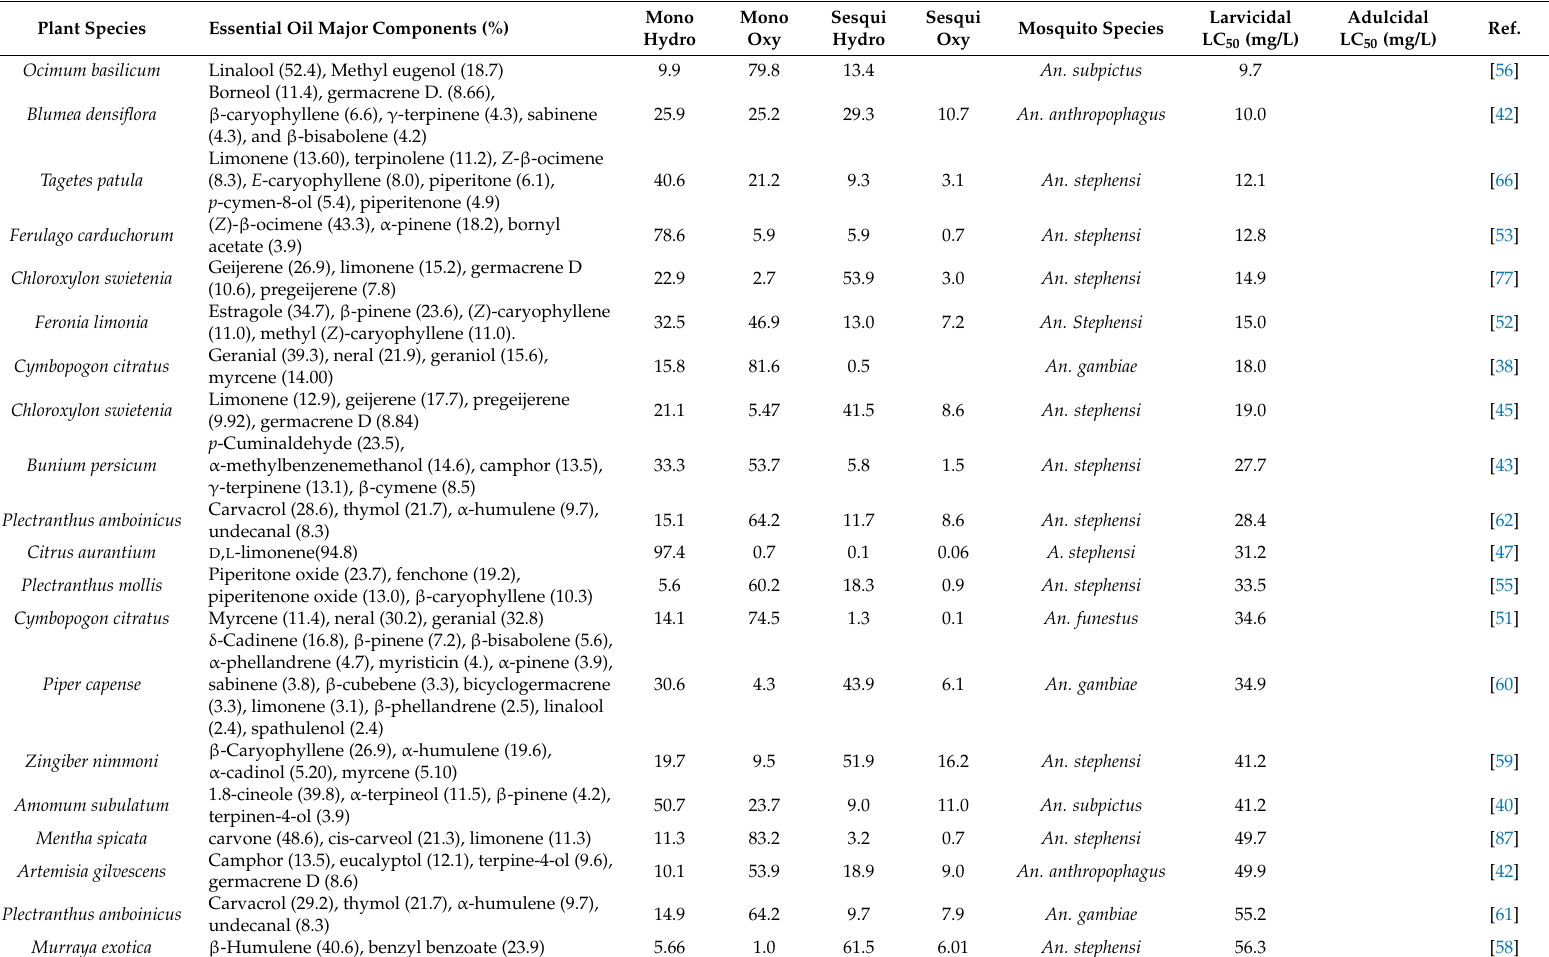
Table 6. Essential oil composition and their activity against Anophelineae